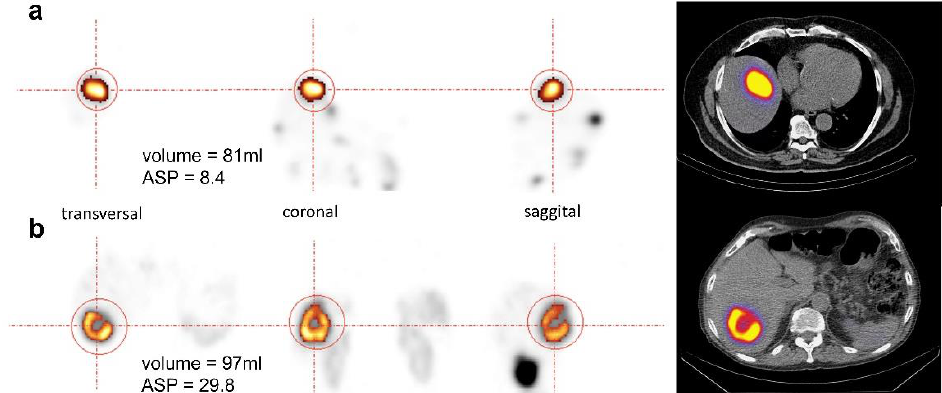
Figure 1. Orthogonal images of two representative examples of neuroendocrine tumors (NET) liver metastases with comparable metabolic tumor volumes (MTV)s, 81 mL ( a ) and 97 mL ( b ), but different asphericity (ASP) values: 8.4% ( a ) and 29.8% ( b ). The delineated somatostatin receptor (SSR)-positive MTV is highlighted by colouring.